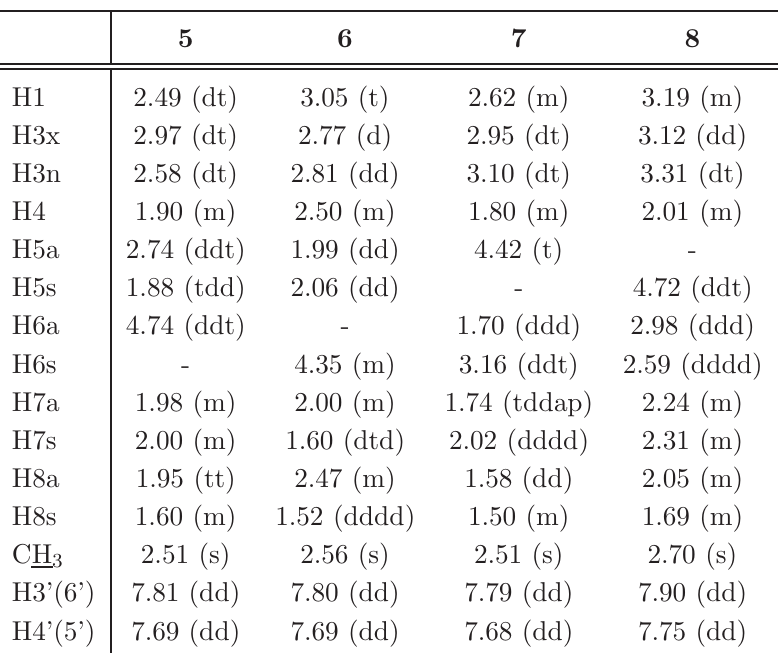
Table 5 1 H Chemical shifts ( δ , ppm) for compounds 5-8 in CDCl 3 . Abbreviations: d, doublet; dd, doublet of doublets; ddd, doublet of doublet of doublets; dddd, double of double doublet of doublets; dt, doublet of triplets; ddt, doublet of doublet of triplets; dtd, doublet of triplet of doublets; m, multiplet; s, singlet; t, triplet; tdd, triplet of doublet of doublets; tddap, apparent triplet of doublet of doublets; tt, triplet of